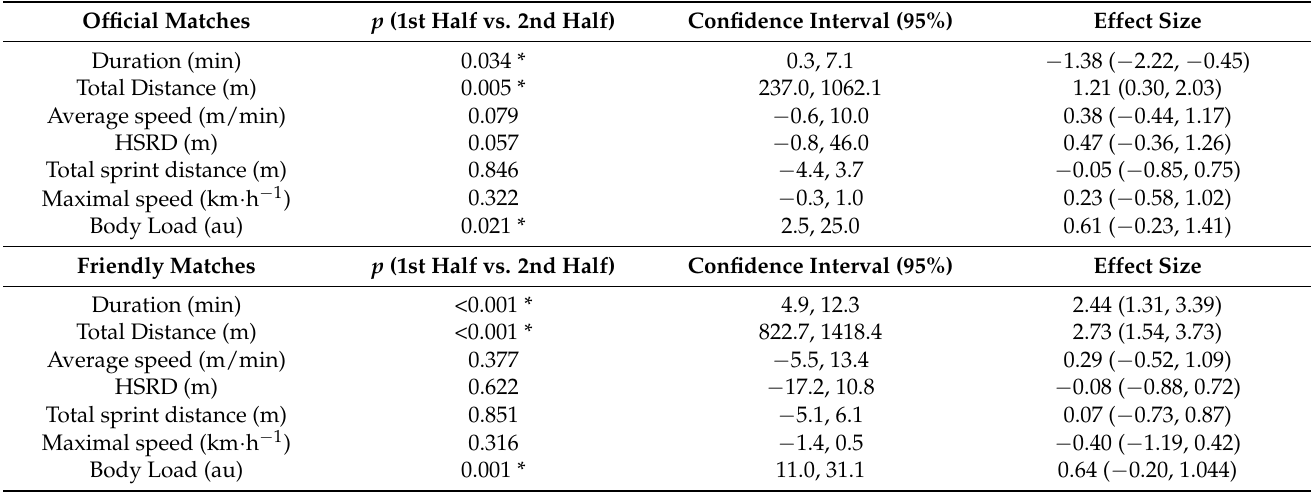
Table 3. Comparison of first and second halves data for official matches and friendly matches,